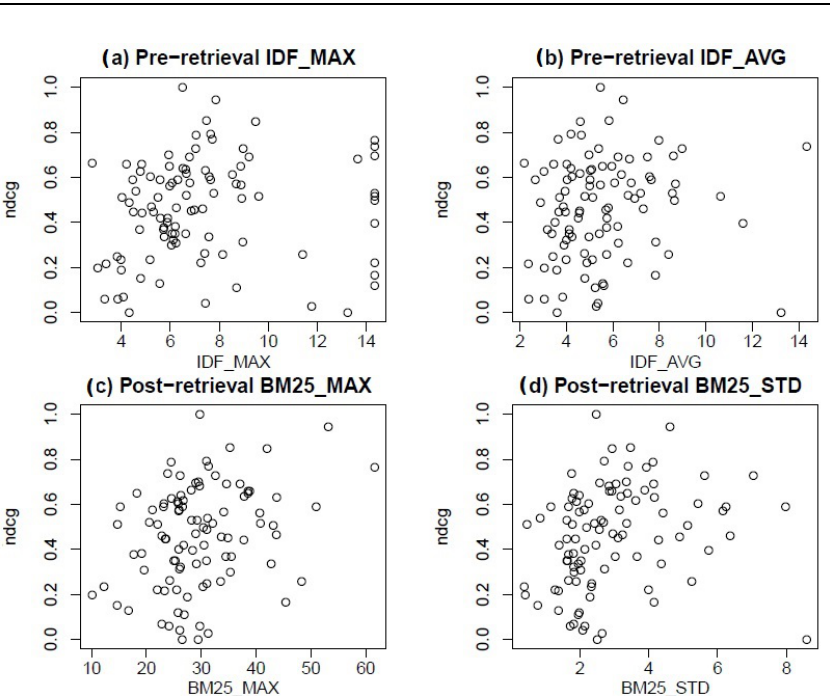
Figure 13. No correlation using pre- or post-predictors with the actual effectiveness—IDF pre- retrieval predictor and BM25 post-retrieval predictor (X-axis) and ndcg (Y-axis) values on WT10G TREC collection. Although the correlation values are up to 0.35, there is no